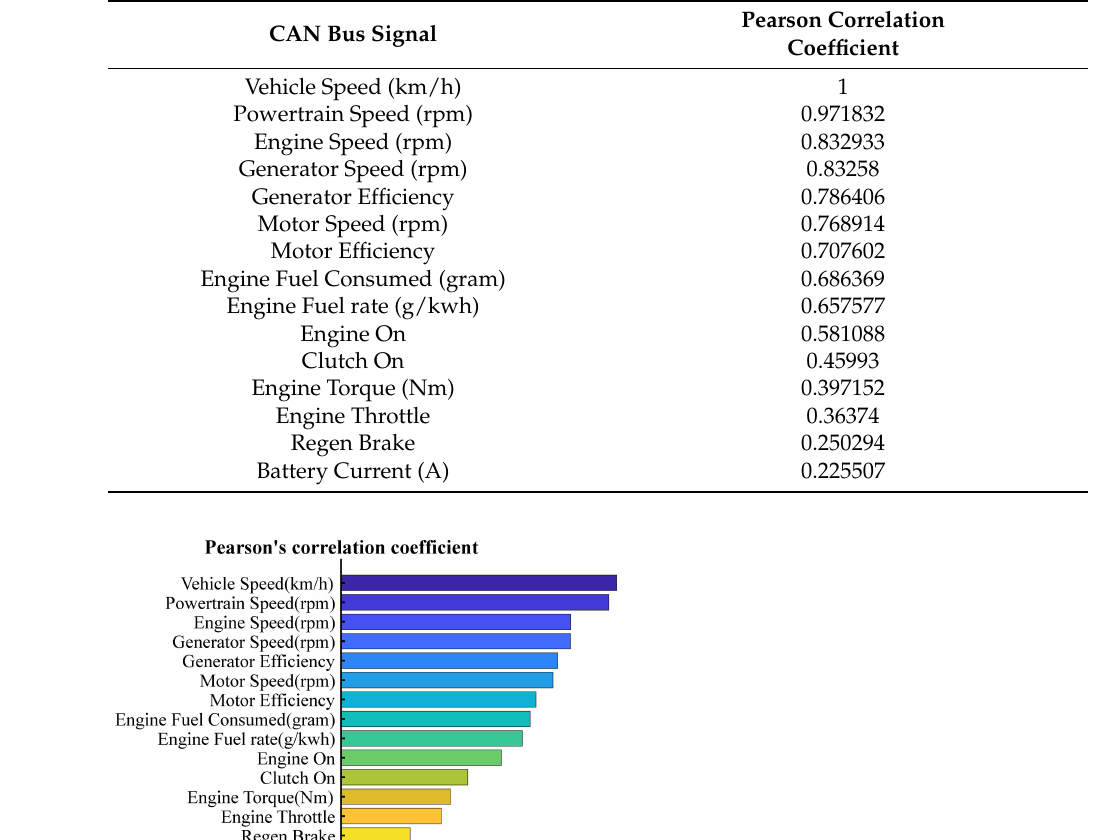
Table 1. Pearson correlation coefficient of selected signals.